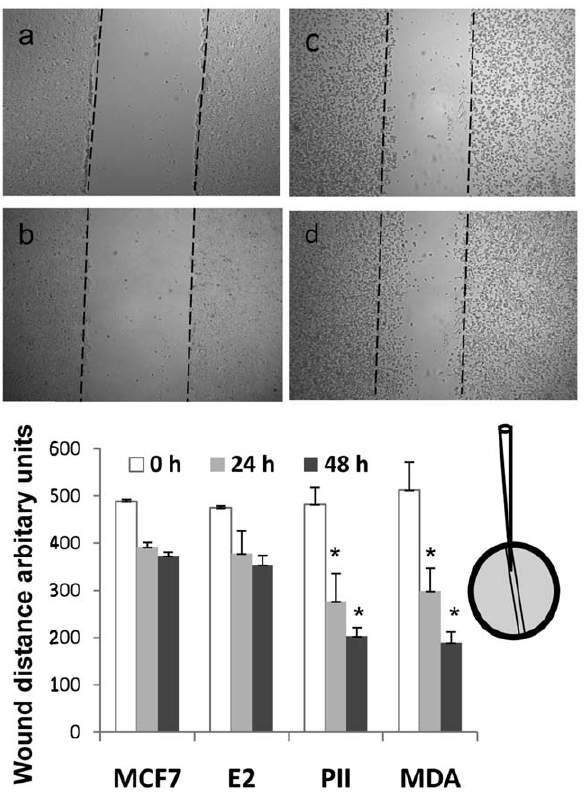
Figure 2. Motility assay of MCF7, pII and MDA231. Cells were plated into individual wells of a 6 well microwell dish and allowed to grow to , 80% confluency. A scratch was made across the centre of the cell monolayer with a yellow eppendorf pipette tip (as shown in cartoon) creating a parallel space. Damaged cells were removed by carefully aspirating off the medium and rinsing with PBS before addition of fresh medium containing 2% serum. Upper panels show comparative microscopic view of MCF7 (a–b) and pII (c–d) cells in the scratched area at 0 time (a, c) and after 24 h [b, d] for a typical experiment. Chart shows the combined quantitated results from 3 independent experiments for the cell lines indicated. Histobars represent the mean [ 6 standard deviation] width of the original scratch space at 0, 24 and 48 h. Wound closure indicates movement of cells into the scratch. *Significantly different from MCF7 cells at respective times with p # 0.006.